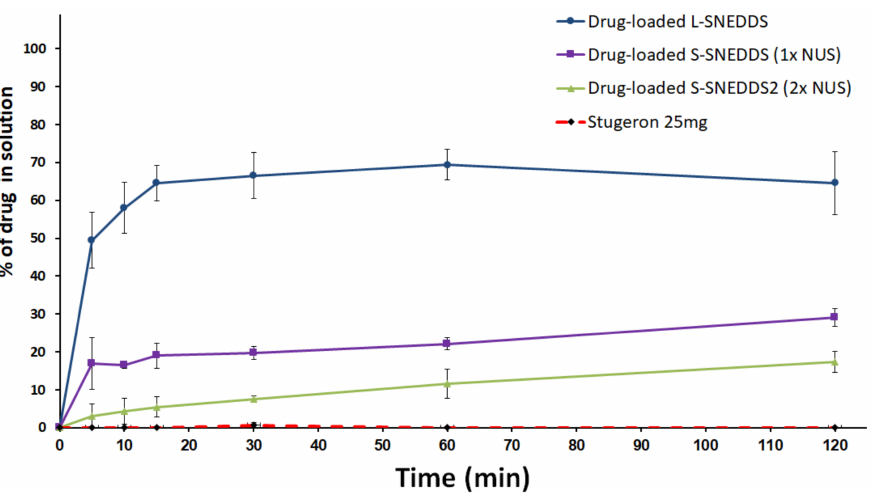
Figure 7. Effect of Neusilin ® US2 on CN release from SNEDDS at pH 6.8. Data are expressed as mean ± SD. n = 3 for drug-loaded L-SNEDDS and Stugeron while n = 6 for drug-loaded S-SNEDDS (1 × NUS) and drug-loaded S-SNEDDS2 (2 × NUS).